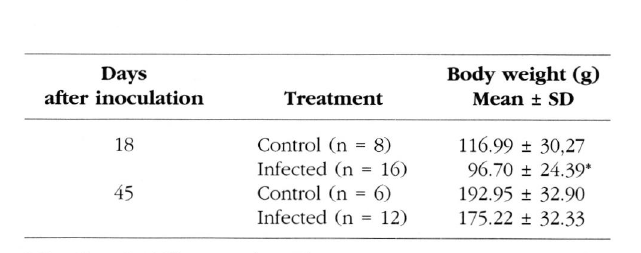
Table I. - The effect of Trypanosoma cruzi infection on body weight